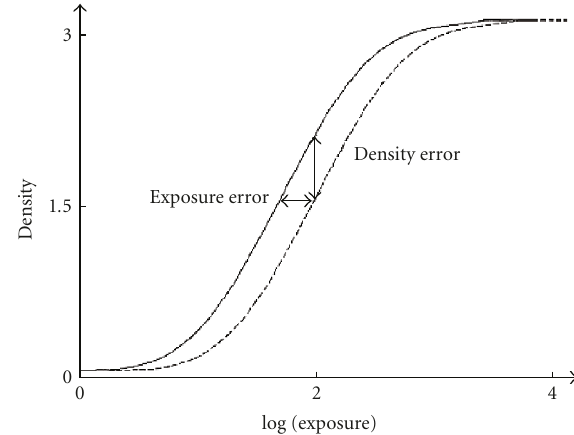
Figure 3: Hurter-Dri ffi eld D (log E ) characteristic (dashed) and density error curve (solid) due to exposure inconsistencies.